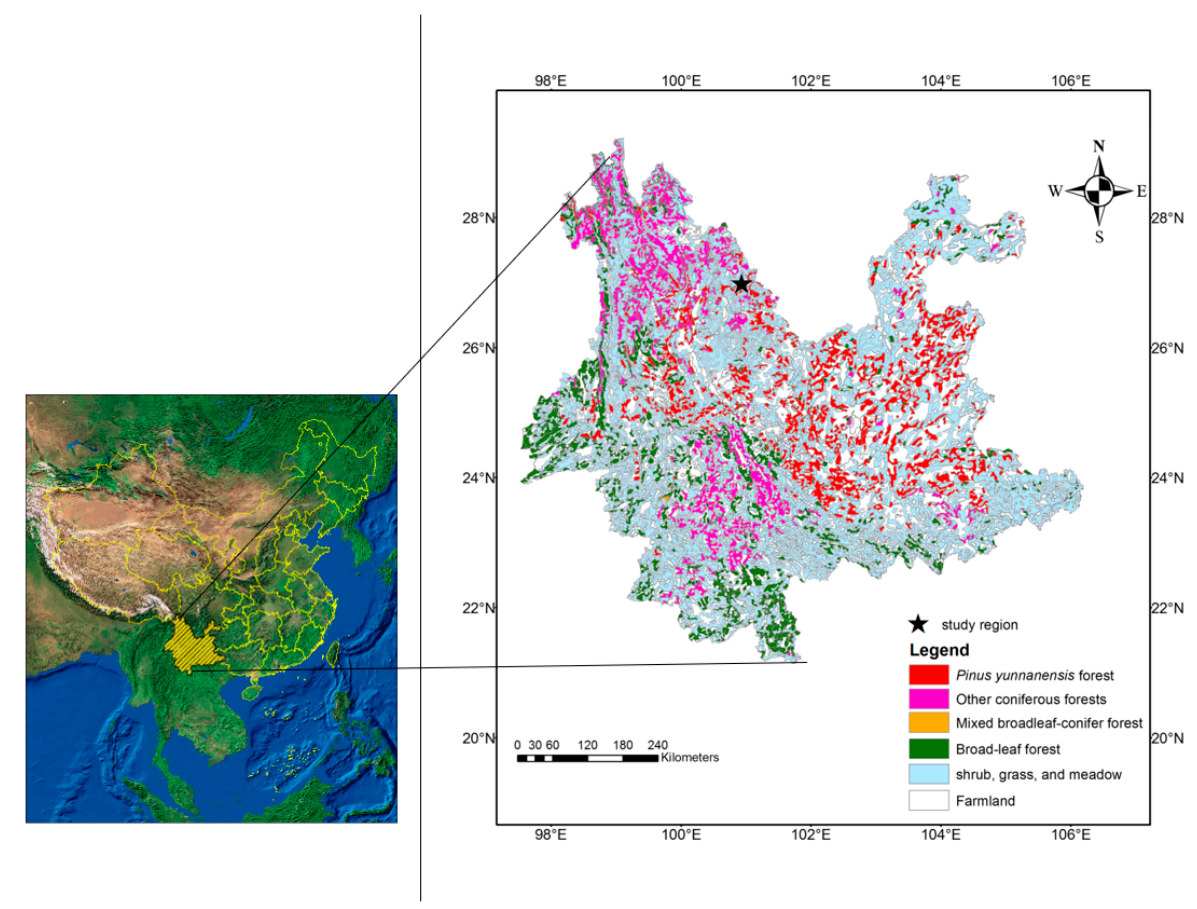
Figure 1. Distribution map showing vegetation types in Yunnan Province.